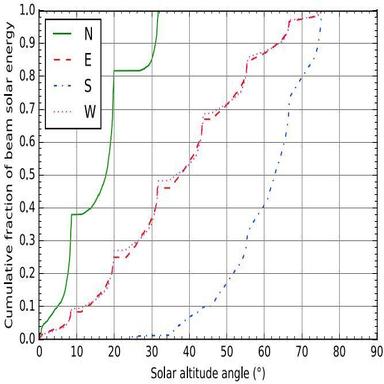
Variation with solar altitude angle of the cumulative fraction of beam solar energy incident on an isolated north (N), east (E), south (S), or west (W) wall in Fresno, CA in summer.